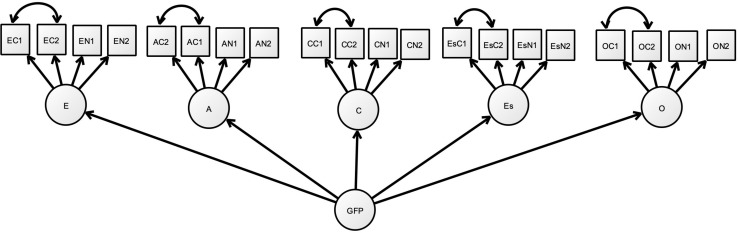
Model used to test for specific competence factors. Abbreviations first letter: E, Extraversion; A, Agreeableness; C, Conscientiousness; Es, Emotional stability; O, Openness. Second letter: C, Competence; N, Non-competence. Third letter: 1, parcel #1; 2, parcel#2; GFP, general factor of personality. Covariance arrows are the ones tested for specific competences.